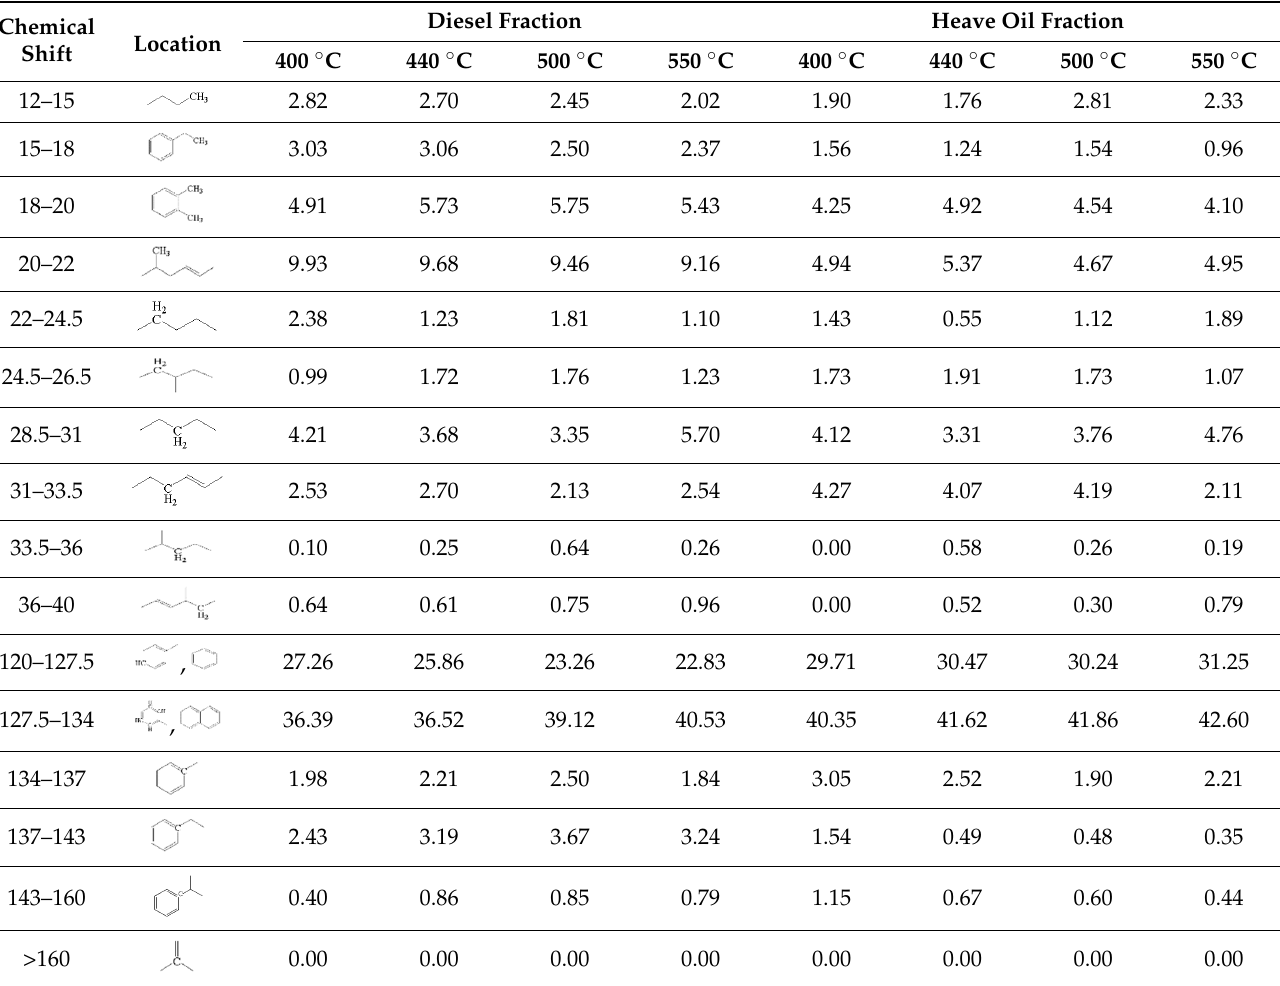
Figure 5. 13 C NMR curves of the liquid samples at different temperatures. ( a ) Diesel fraction; ( b ) heavy oil fraction. (Figure 3; the signal at 77 ppm is assigned to the solvent of the NMR measurement). The carbon skeleton structure information corresponding to different chemical shifts is listed in Table 1. Table 1. 13 C NMR analysis results of different samples.